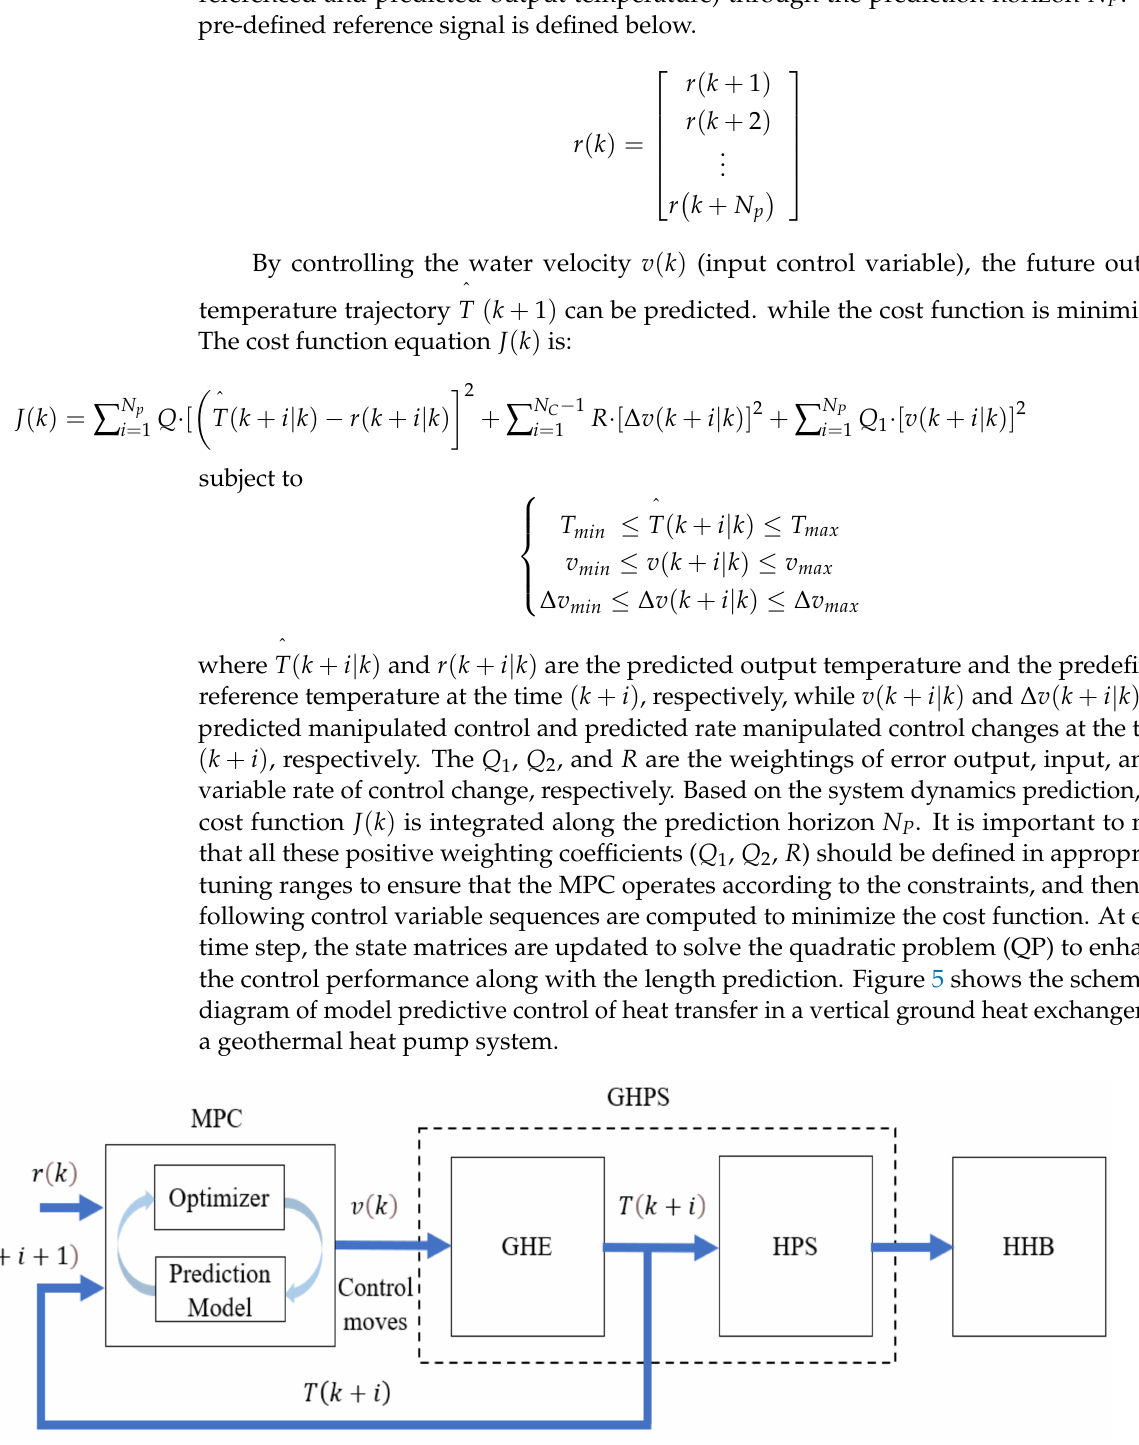
Figure 5. Schematic diagram of closed-loop controlling heat transfer in a ground heat exchanger for a geothermal heat pump system with MPC, where MPC is model predictive control, GHE is ground heat exchanger, HPS is heat pump system, GHPS is geothermal heat pump system, HHB is Human Health Building at Oakland University, r ( k ) is reference signal, T ( k ) is temperature, and v ( k ) is water